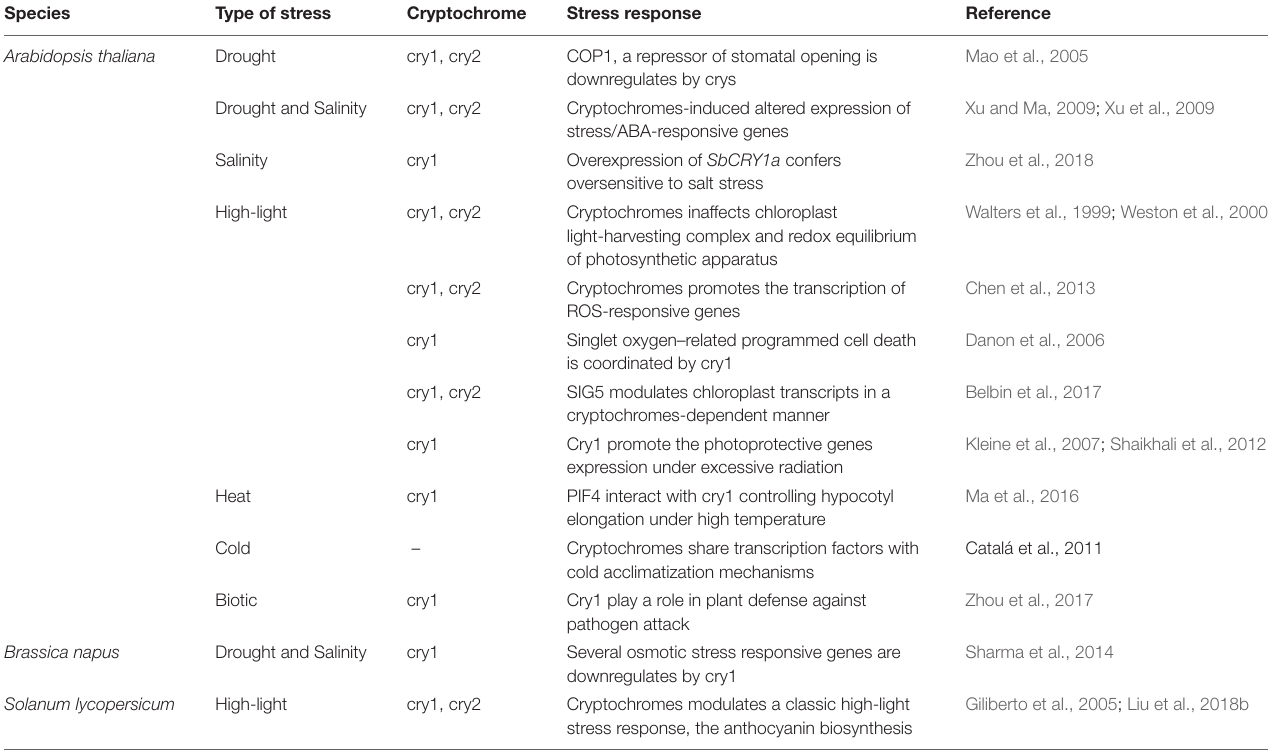
TABLE 1 | General description of stress responses controlled by cryptochromes in